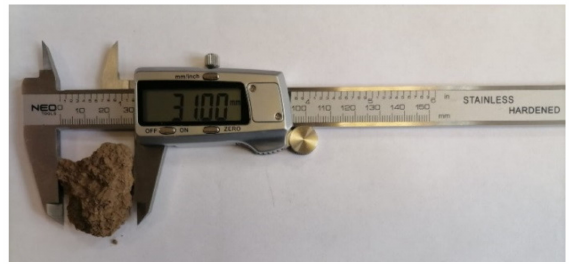
Figure 7. Determination of the dimensional characteristics of soil